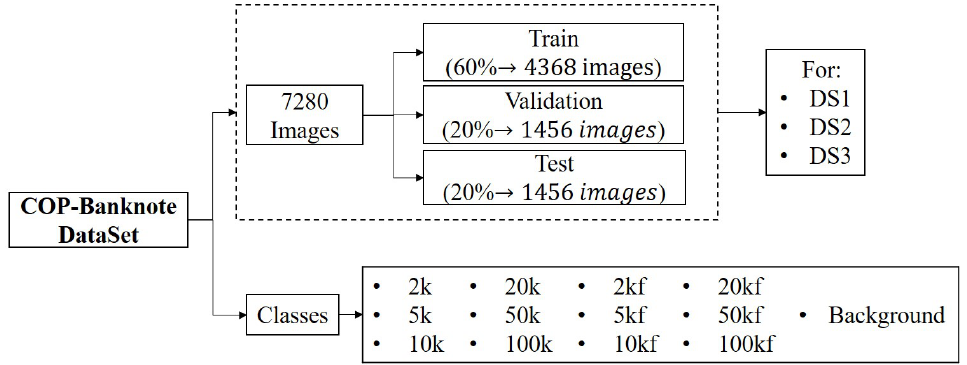
Figure 7. Characteristics of the dataset used (Colombian banknotes): number of images, image distribution and